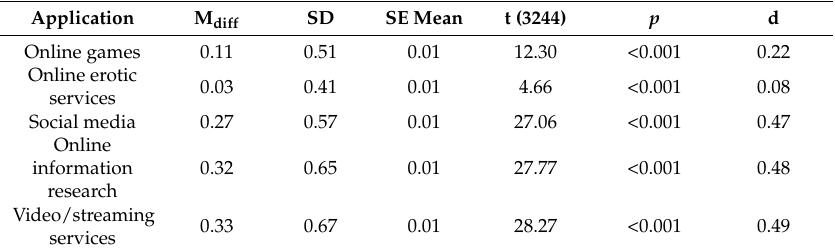
Table 3. Results of the paired samples t -tests assessing differences of the online media consumption before and during the COVID-19 lockdown